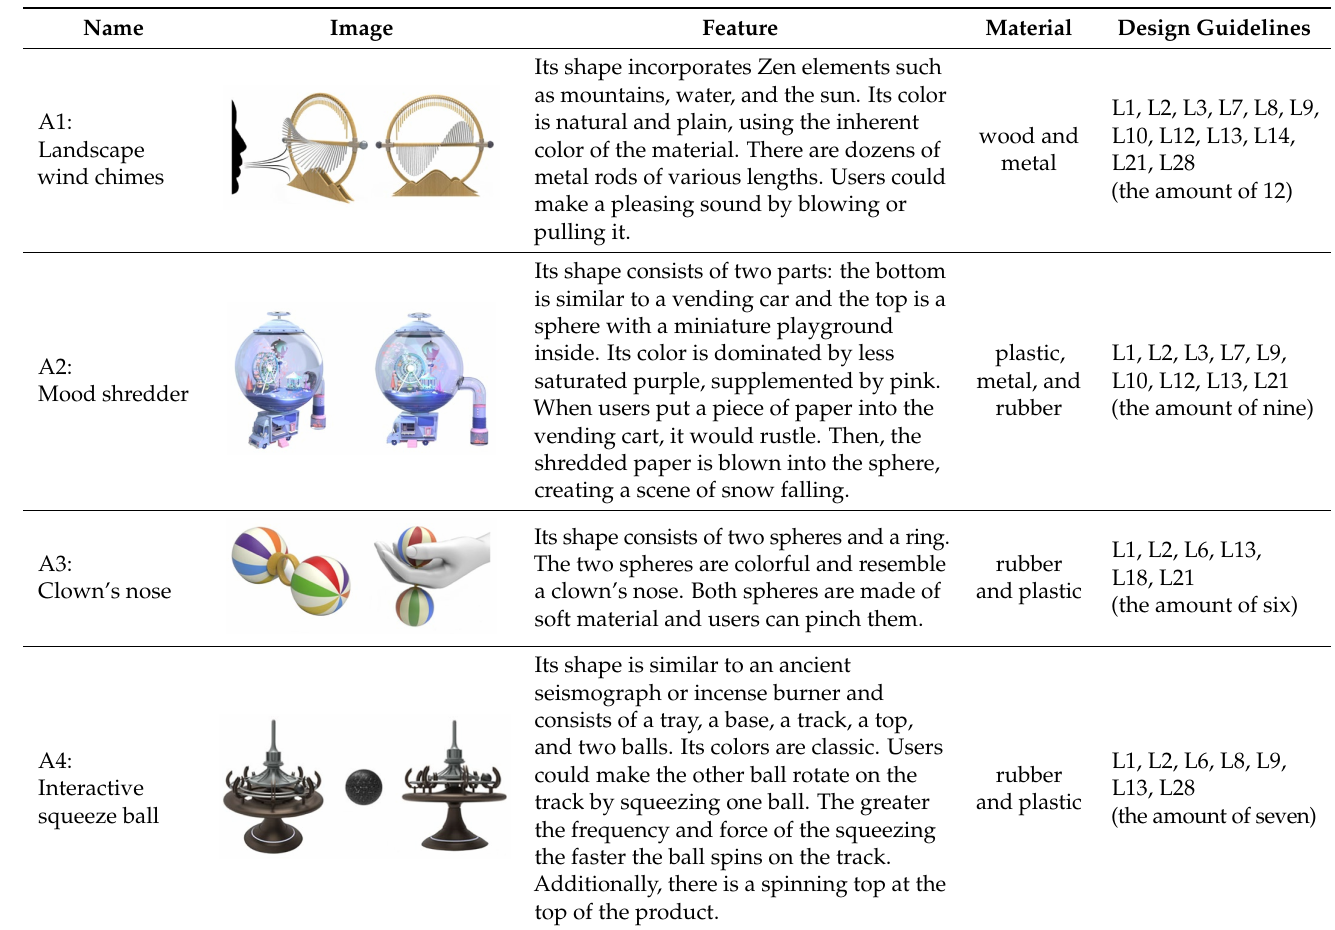
Table 9. Information table about the four